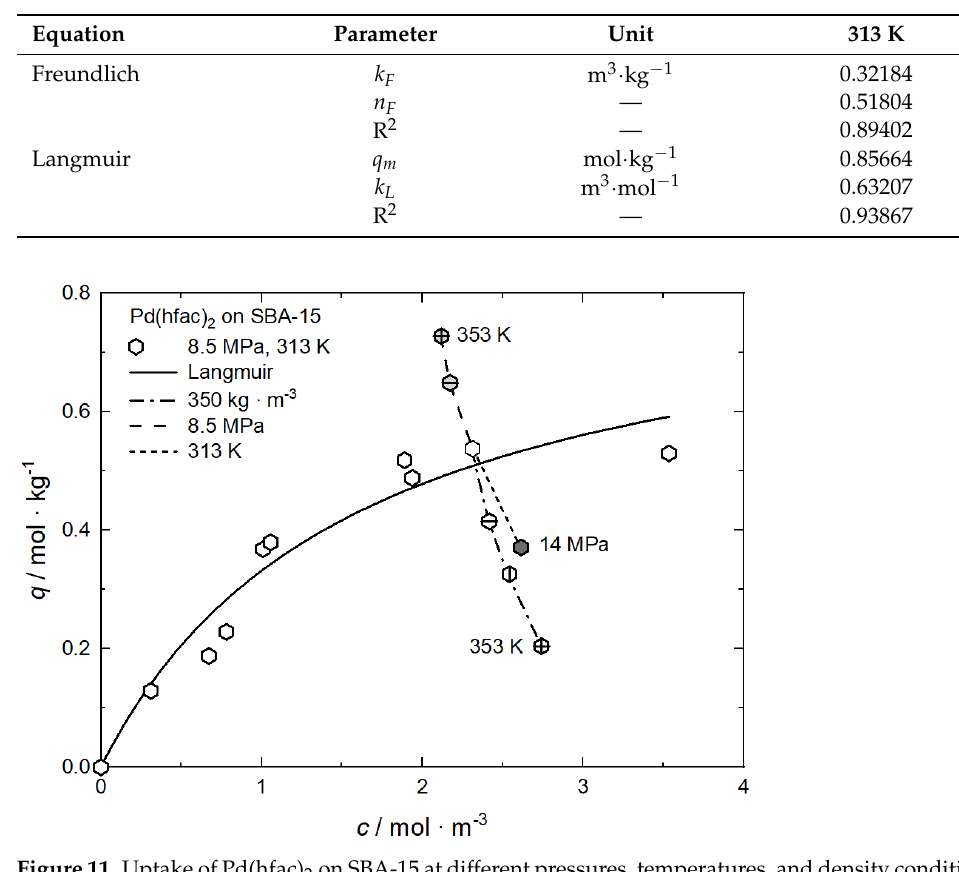
Figure 11. Uptake of Pd(hfac) 2 on SBA-15 at different pressures, temperatures, and density conditions; experimental data taken from [9].